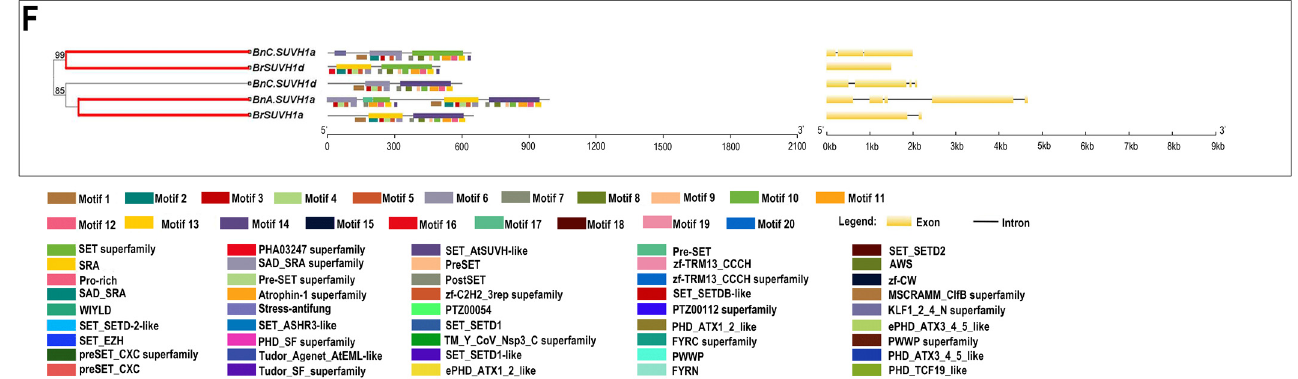
Figure 2. Intron/exon structure and conserved domain and motif overlap characterizations of the SUV gene family in B. napus , B. rapa and B. oleracea . ( A – F ): The characterizations of the SUV in the clade A to F. Note: The left part is the phylogenetic tree of the SUV gene family. In the red branches, 30 groups of orthologous gene pairs between B. napus and its diploid ancestors may have direct evolutionary relationships. The middle part is the overlap of protein domains and motifs (for each gene, the domain on the line and the motif under the line). The right part shows the gene structure.